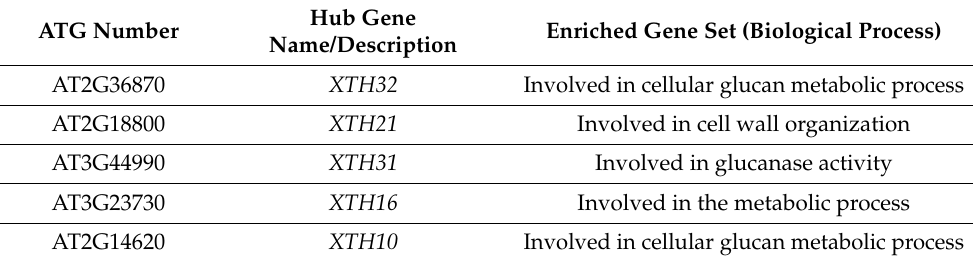
Figure 8. Gene regulatory sub-graph for the process of cell wall biosynthesis in Arabidopsis thaliana WS ecotype in spaceflight total light environment. Table 4. Root growth hub genes with transcriptional abundance in spaceflight microgravity and their most prominent gene